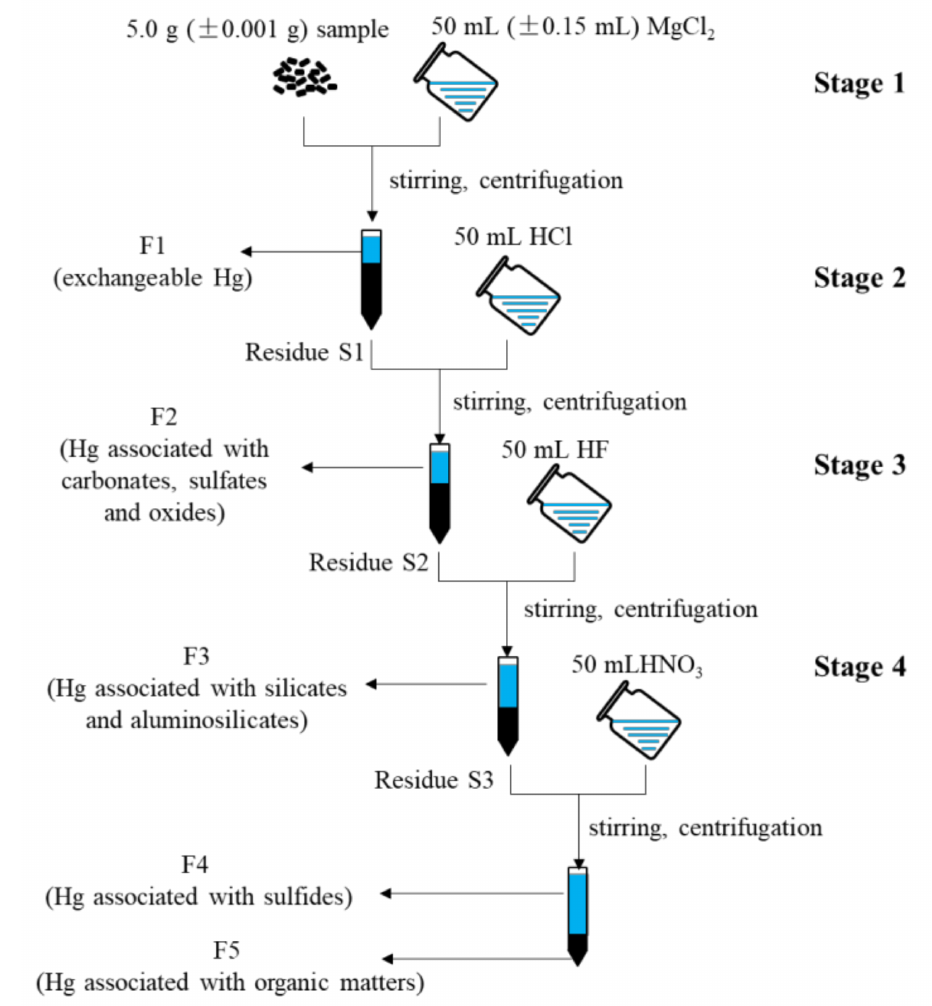
Figure 1. Schematic diagram of SCE procedure for selection of Hg fractions. Stage 1: 5.0 g ± 0.001 g coal sample was extracted by 50 mL ± 0.15 mL MgCl 2 to liberate exchangeable Hg (F1). The residue in this stage was free of